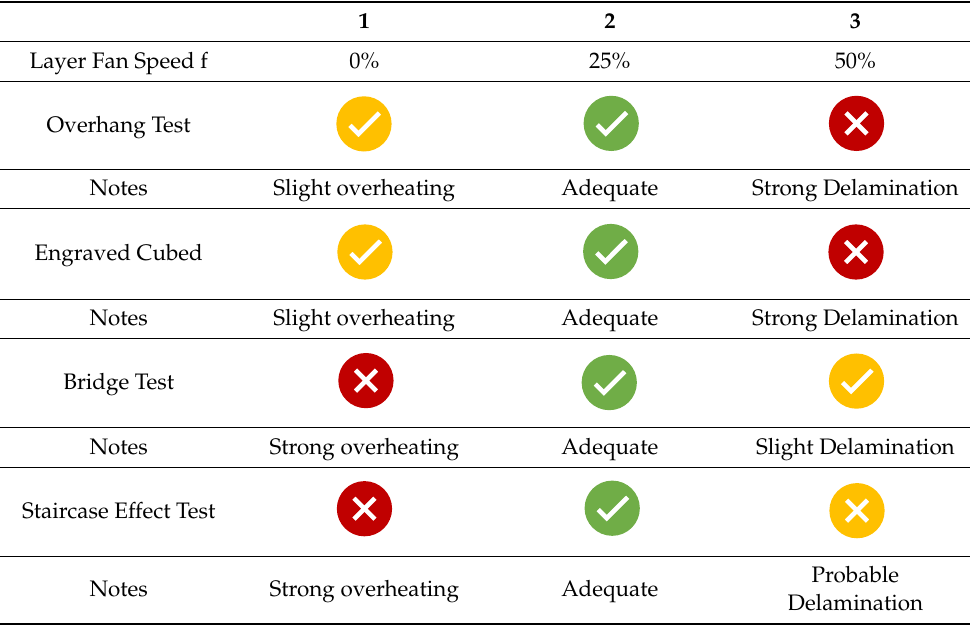
Table 5. Layer fan speed sensitivity analysis results.